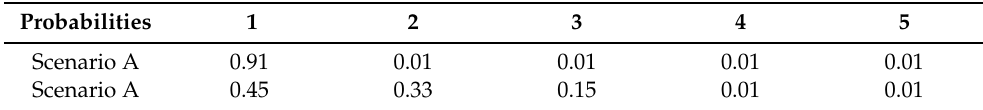
Table 1. Two scenarios for the membership probability according to similarity to each class distribu- tion in a 5-class